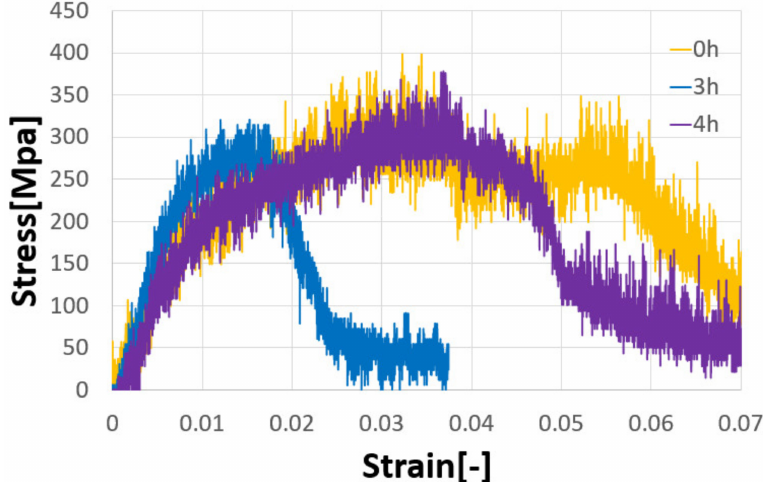
Figure 8. Stress-strain diagrams for 0.5 mass.% CNT / Al composites from the three-point bending tests.